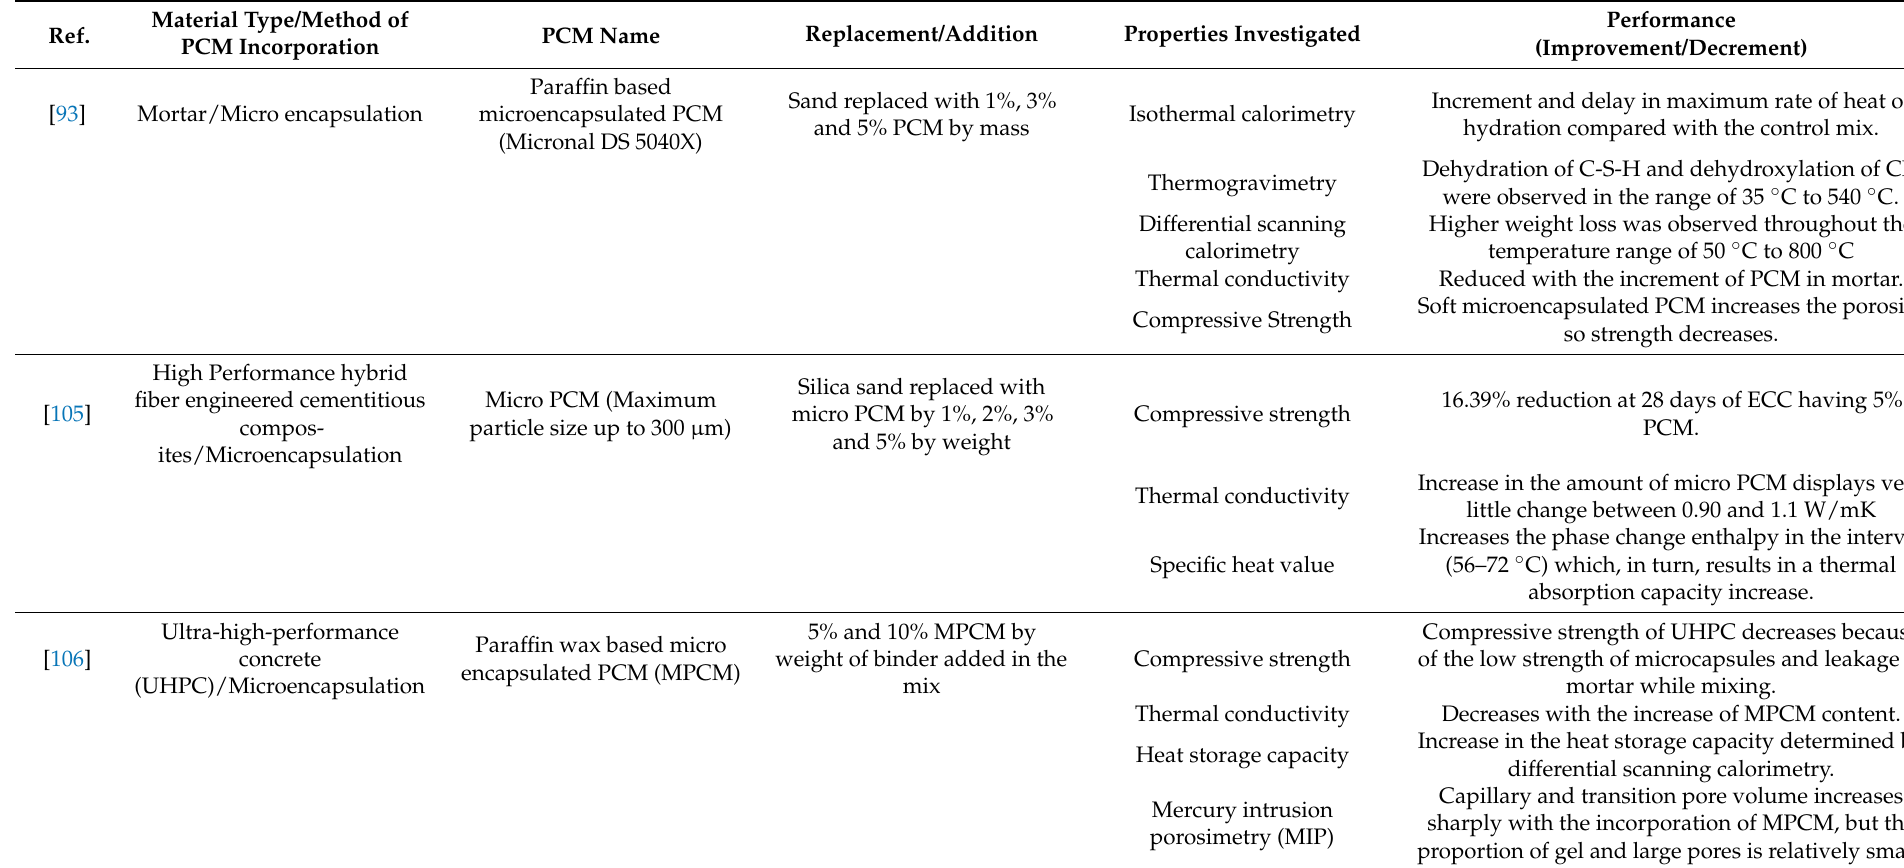
Table 2. Different method of incorporating the PCM in concrete/mortar and their performance outcome.